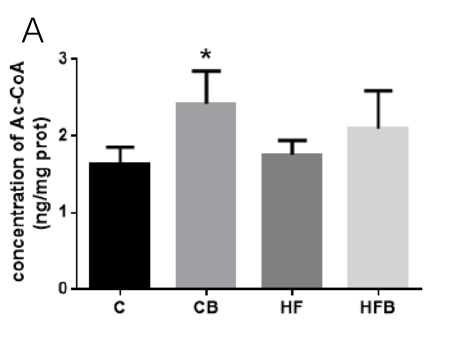
8 of 16 Figure 4. Effects of betaine and high-fat diet on hepatic metabolites in rats ( n = 8). * Significantly different from the C group ( p < 0.05). # Significantly different from the HF group ( p < 0.05). ( A ) Level of hepatic triglyceride. (BET, p = 0.303, FAT, p < 0.001, interaction, p = 0.836). ( B ) Level of hepatic total cholesterol (TC) (BET, p = 0.036, FAT, p = 0.436, interaction, p = 0.145). ( C ) Level of total bile acids (TBA) in the liver (BET, p = 0.006, FAT, p = 0.604, interaction, p = 0.314). 3.4. Key Factors Involved in Cholesterol Metabolism 3.4.1. Cholesterol Synthesis CPT1 is a key enzyme for β-oxidization of fatty acid in liver. Ac-CoA is a vital material for cholesterol biosynthesis. As shown in Figures 5 and 6, the levels of hepatic CPT1 and AC-CoA were both significantly increased by betaine addition rather than affected by the high-fat diet in rats ( p < 0.05). HMGCR is the rate-limiting enzyme during cholesterol synthesis in liver. As can be seen from Figure 6, the high-fat diet remarkably enhanced the level of hepatic HMGCR in rats ( p < 0.05). Furthermore, betaine addition increased the level of hepatic HMGCR in rats compared to the control group ( p = 0.05), but its addition showed no effect on the hepatic HMGCR level when rats were fed with a high-fat diet ( p > 0.05). A two-way ANOVA test showed that betaine’s effect on the hepatic HMGCR level was not significant ( p > 0.05). C